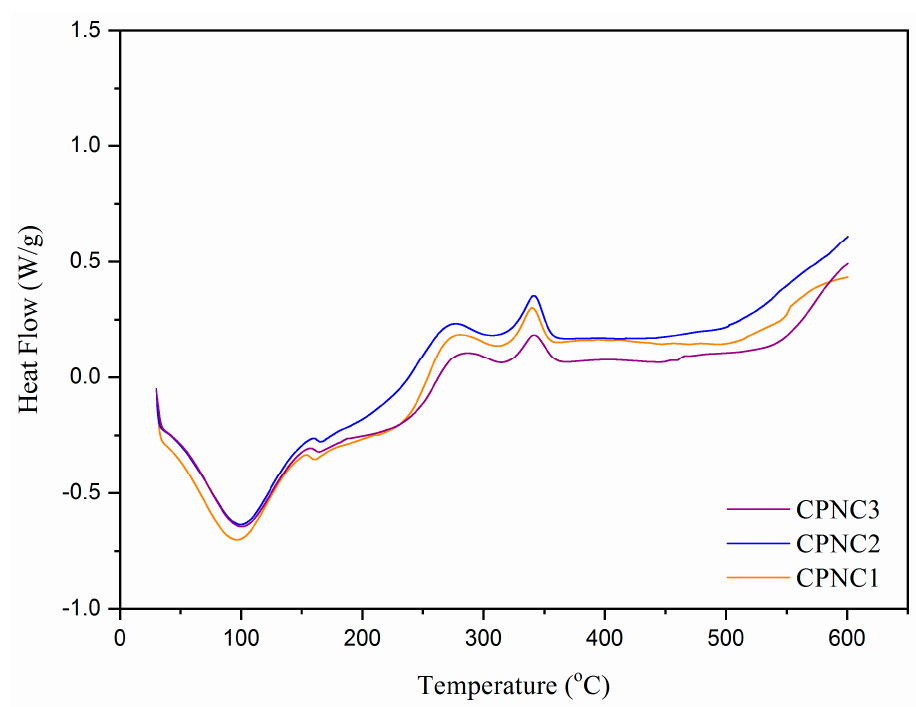
Figure 6. DSC spectra of CPNC1, CPNC2 and CPNC3 samples.